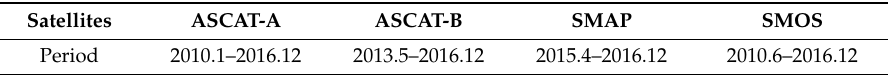
Table 1. Periods of satellite products chosen for this